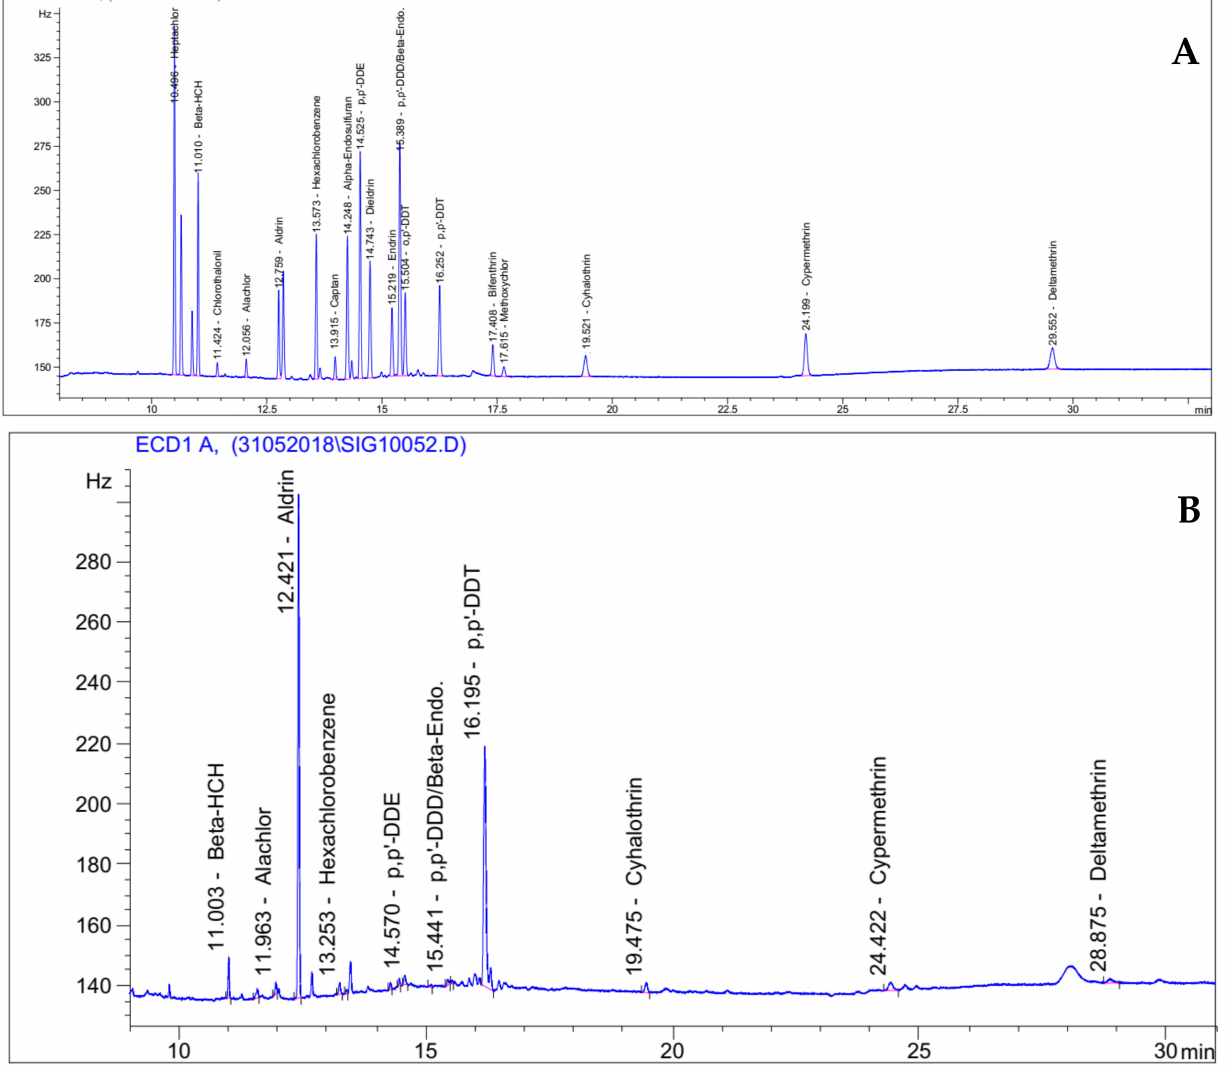
Figure 1. Examples of gas chromatography-electron capture detector (GC-ECD) chormatograms for the standards at 0.01 mg/L ( A ) and a kidney bean sample ( B